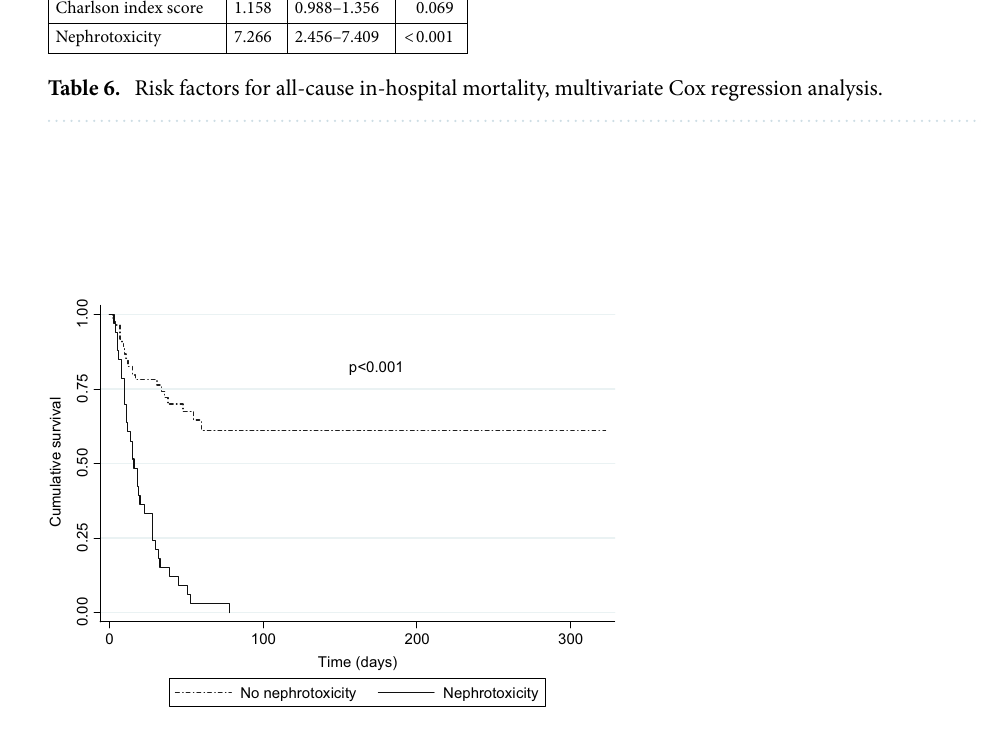
Figure 2. Kaplan–Meier survival curve for patients with nephrotoxicity and without (log-rank